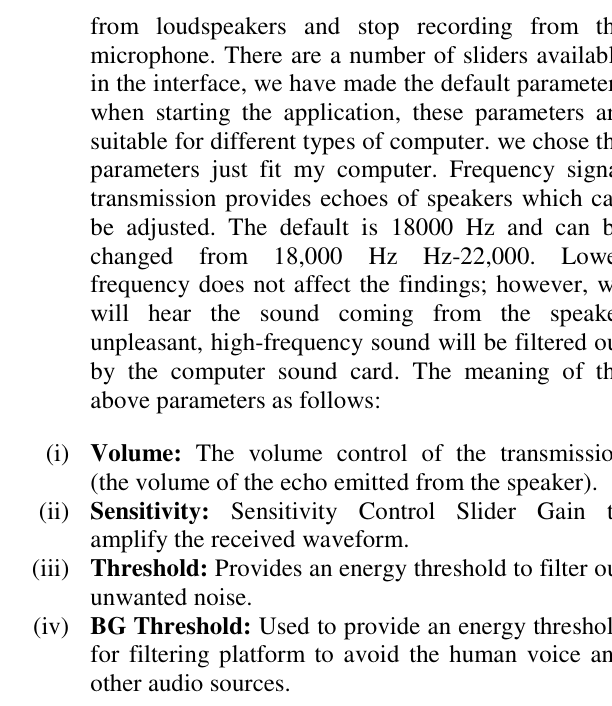
Figure 16. Our application program interface. This program provides a simple user